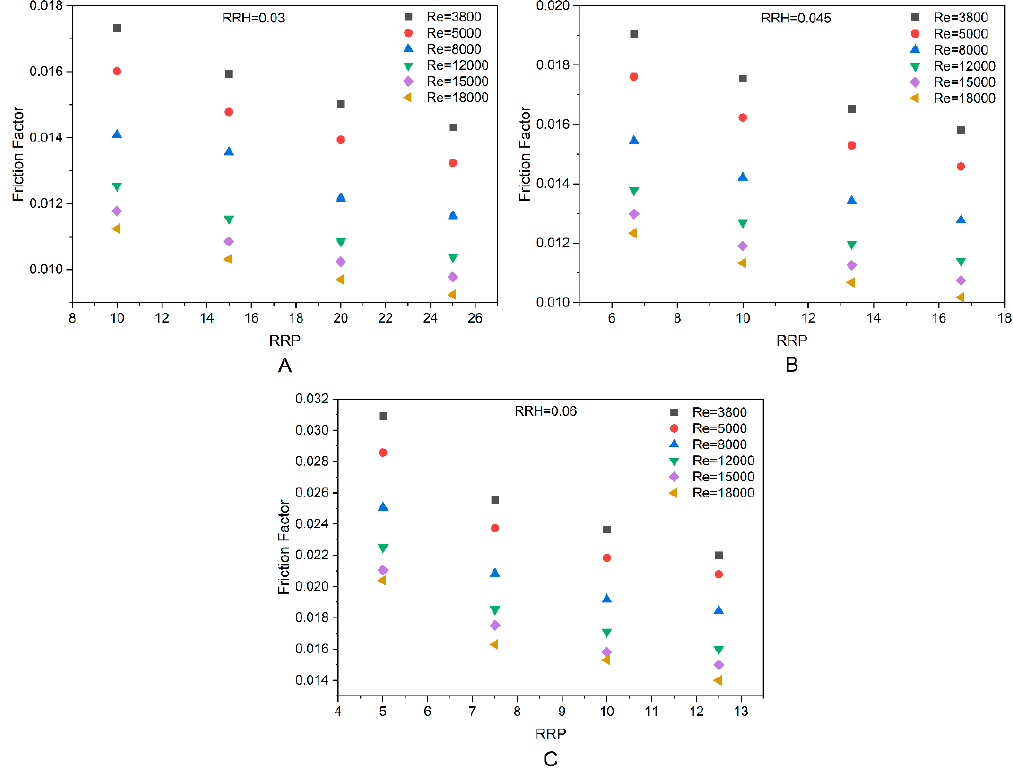
Figure 12. f r versus Re for ( A ) RRH = 0.03, ( B ) RRH = 0.045, and ( C ) RRH = 0.06.